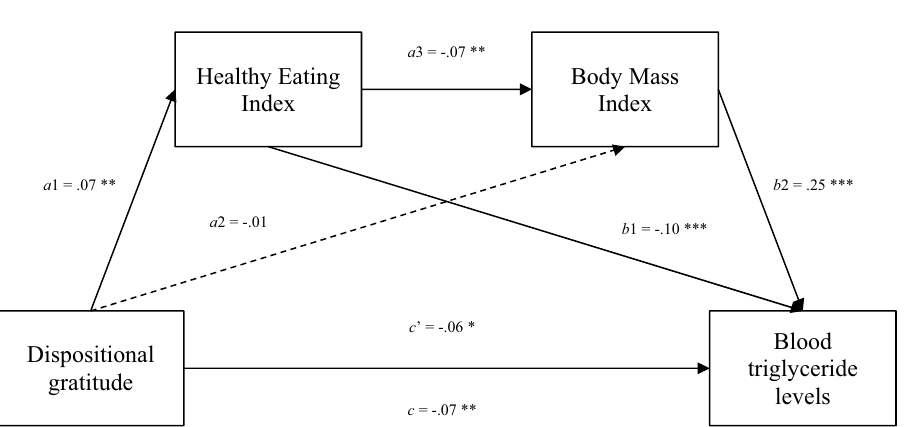
Figure 1. Serial mediation model for triglyceride levels. Note N = 1704. Serial mediation modelling demonstrates the influence of dispositional gratitude on blood triglyceride levels via the healthy eating index and body mass Index. a1, a2, a3, b1, b2, c, and c’ represent path coefficients in standardized forms. c and c’ represent the total effect and direct effect respectively. The model additionally controlled for age, sex, education attainment, household income, race, the use of hyperlipidemic agent medication, dispositional optimism, agreeableness, conscientiousness, extraversion, emotional stability, and openness to experience. Listwise deletion was used as an imputation method for the serial mediation analysis. Listwise deletion was used as Markov Chain Monte Carlo (MCMC) multiple imputation using mice version 3.13.0 and mitml version 0.4-3 was not compatible with PROCESS version 4.0.1 for